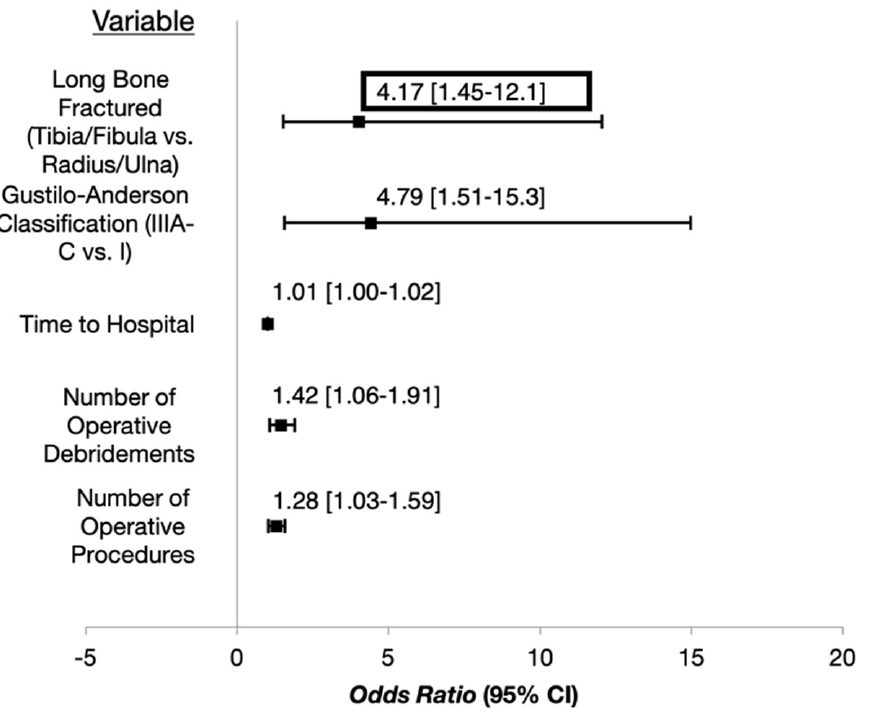
Figure 2. Odds Ratios and 95% Confidence Intervals for Factors Significantly Associated with D-veloping a Deep Infection After Pediatric Open Long-Bone Fractures.